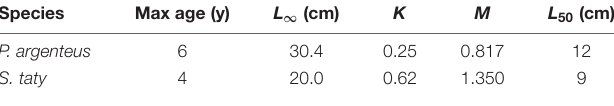
TABLE 1 | Life history parameters for each species assumed in the models; where L ∞ and K are the von Bertalanffy asymptotic length and Brody growth coefficient, respectively and L 50 is the length at which 50% of the population is mature.